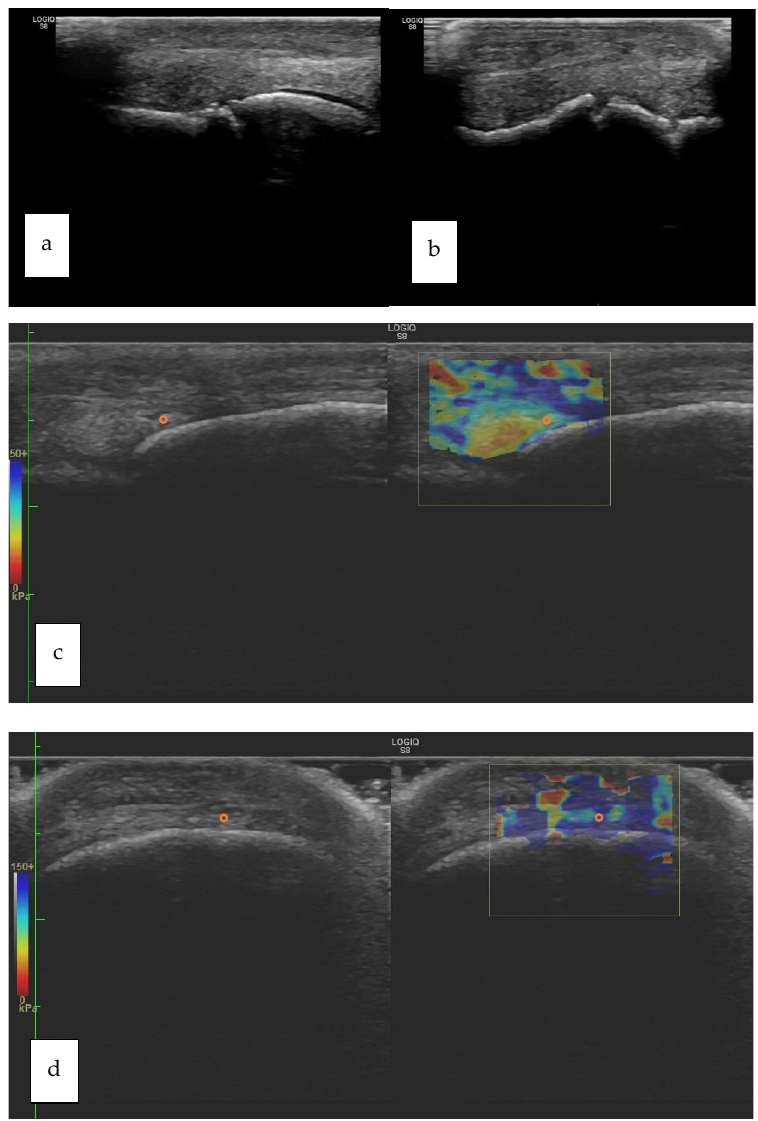
Figure 4. ( a – d ): longitudinal ( a ) and transverse ( b ) B-mode images of a right fore fetlock joint showing bone remodeling of the third metacarpal bone (McIII); longitudinal ( c ) and transverse ( d ) views of the metacarpophalangeal joint of a horse belonging to Group P. The orange circle that is superimposed to the elastogram shows the positioning of the ROI. The B-mode corresponding to each elastogram is shown on the left of each box (Group P: horses affected by osteoarthritis; ROI: Region of Interest). Table 3. Velocity (m/s) and Young’s modulus (kPa) in Group S and Group P in left and right limb. Values are expressed as median and range. Statistical significance was set at p <